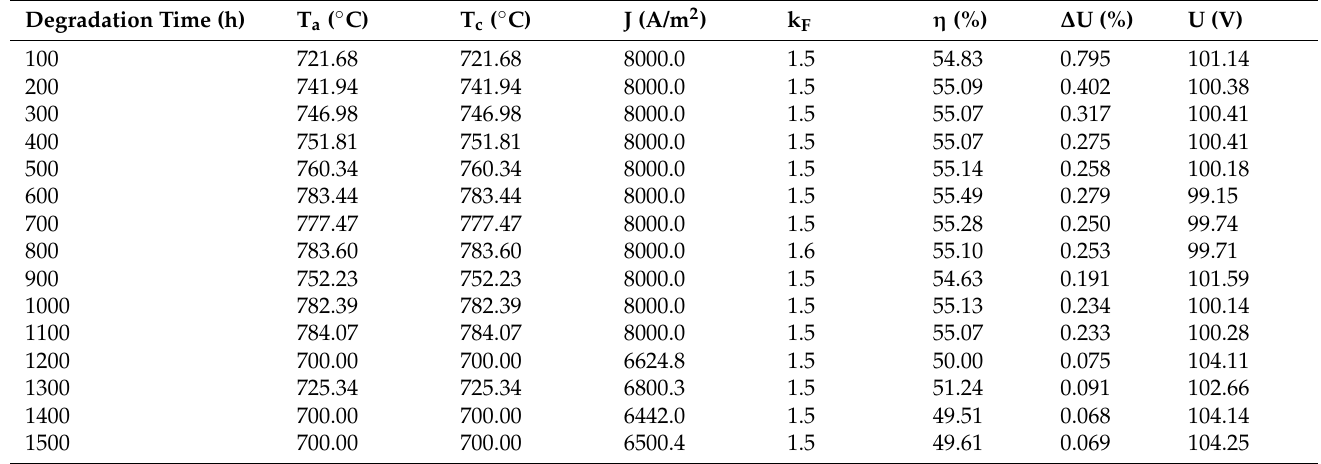
Table 3. The optimal point selection records during optimization.